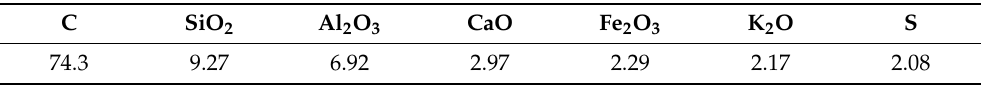
Table 1. Quantitative XRF analysis of the natural graphite material